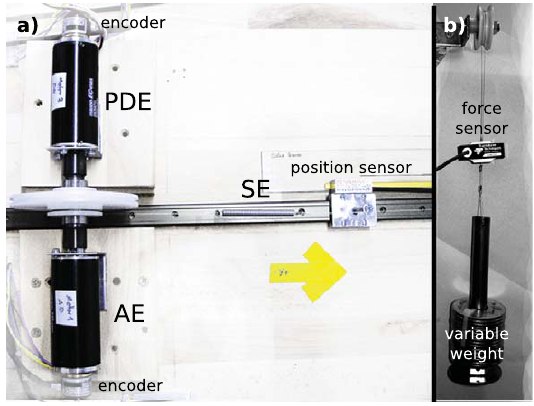
Fig. 4. Picture of the assembly. The components are connected with steelwires.Encodersrecordthepositionofthemotorshafts( y 1 ).The position sensors (for y 2 ) is mounted to a linear guide and attached to the steel wire between spring and force